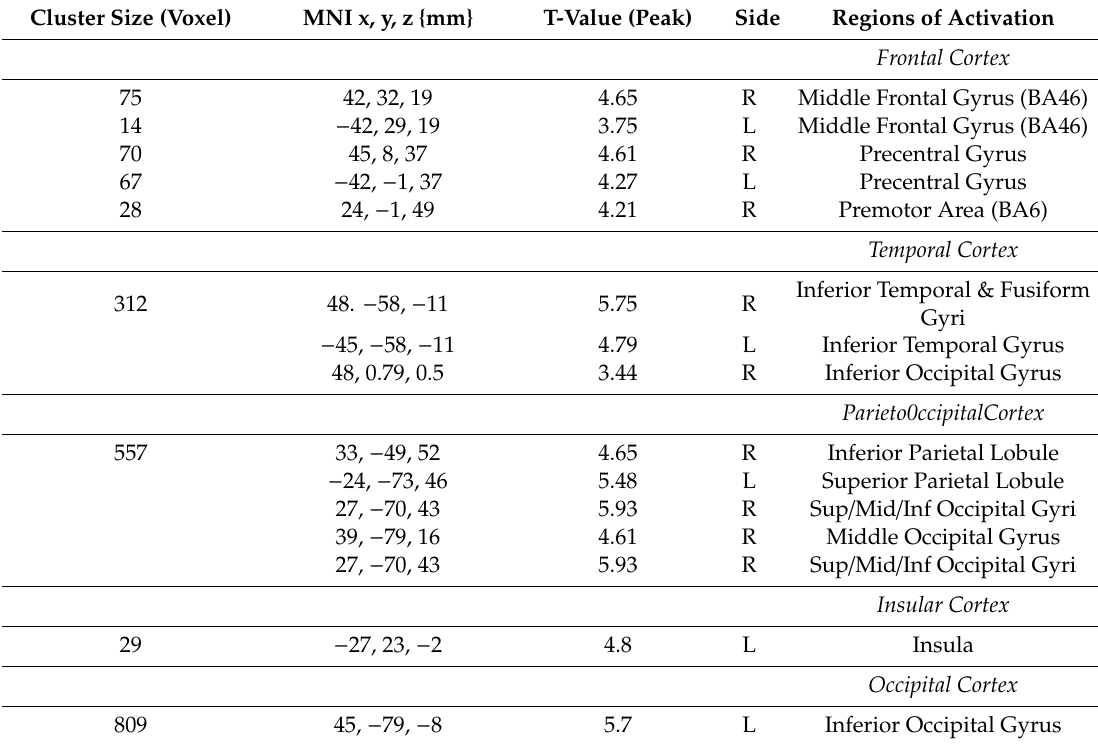
Table 3. Subtraction analysis: Novel CS > Familiar CS 1 .